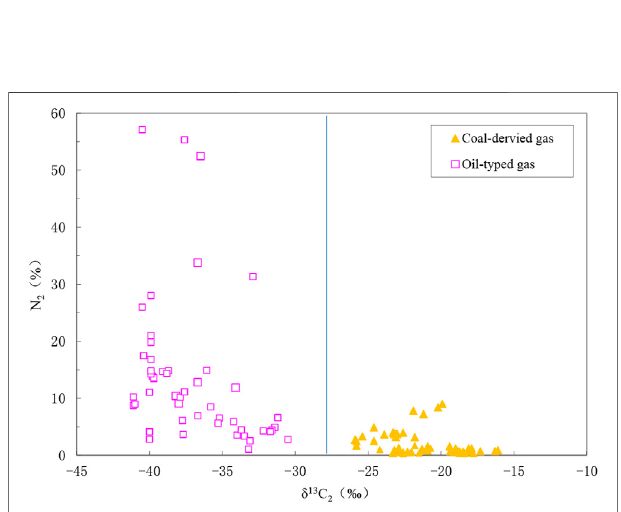
FIGURE 3 | Relationship between nitrogen content and ethane isotope δ 13 C 2 of coal-derived gas and oil-typed gas in China.